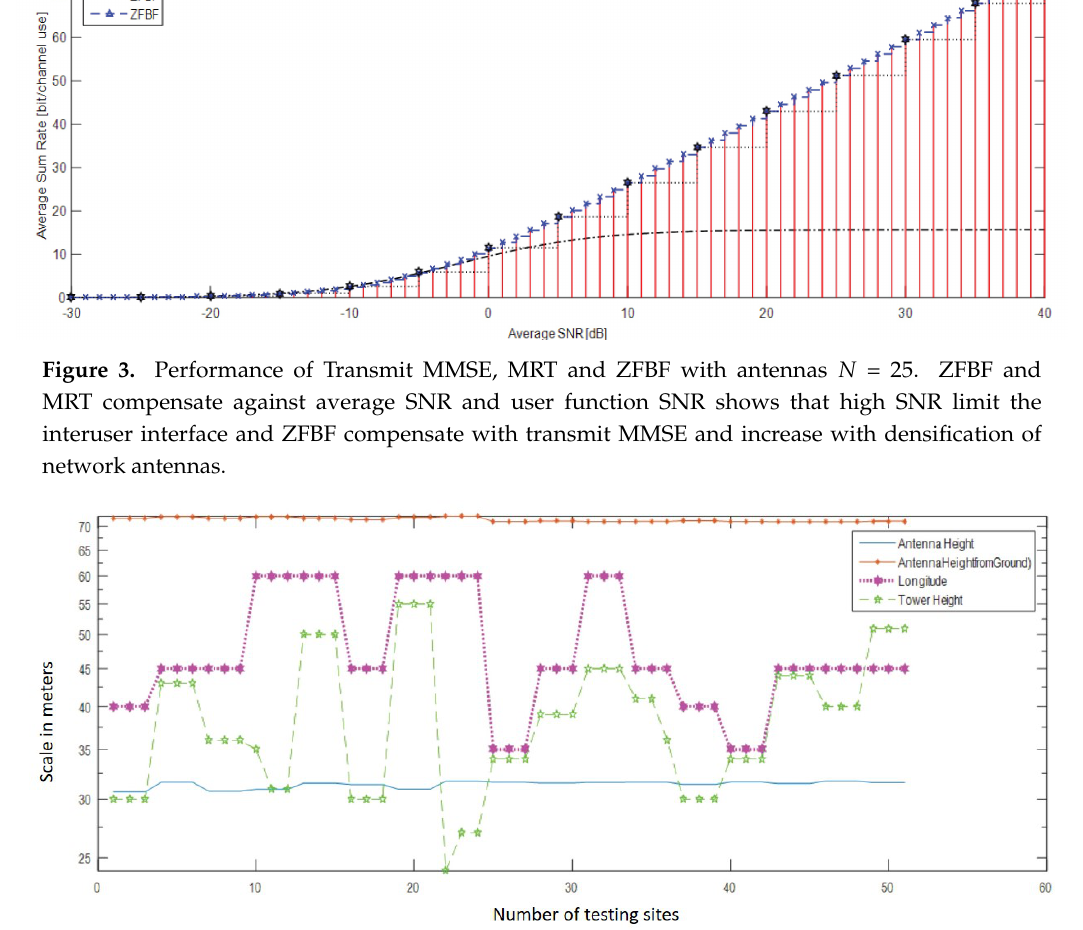
Figure 4. Comparative analysis on 15 MHz-bands for 4G technology with antennas height and tower heights in meters, with longitudinal variations for the